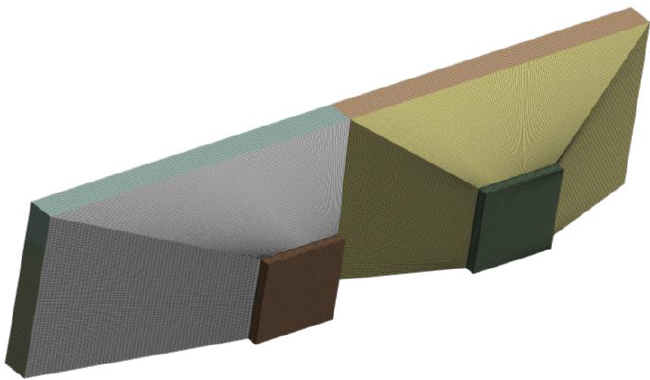
Figure 7. Fluid Domain Meshing Model.